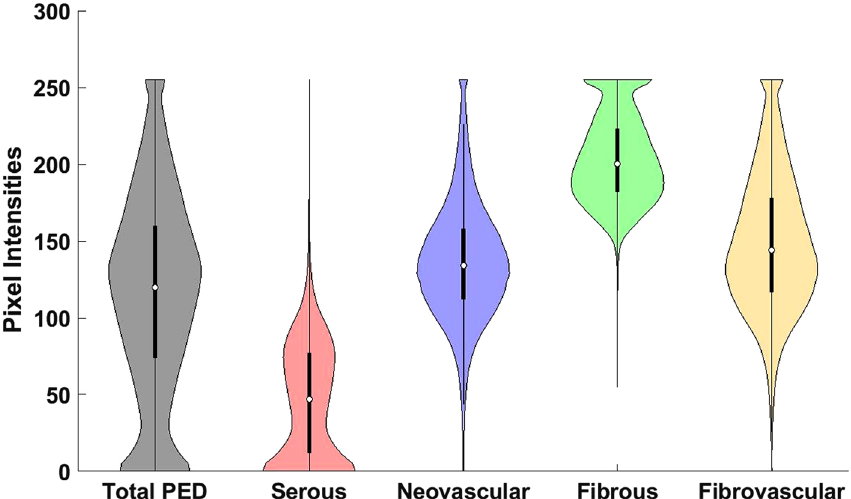
Figure 3. Violin plot showing the distribution of pixel intensities from different components of a pigment epithelial detachment (PED). Pixel intensities correspond to pre-processed spectral-domain optical coherence tomography images taken from 43 eyes with neovascular age-related macular degeneration. Mutually exclusive classified components include serous, neovascular, and fibrous. Fibrovascular is the combined distribution of neovascular and fibrous tissue. Total PED is the combined distribution of serous, neovascular, and fibrous tissue. The overlap in the distributions indicates the difficulty in separating tissue types, particularly neovascular and fibrous tissue. The skewed distribution of fibrovascular tissue indicates more than one underlying tissue